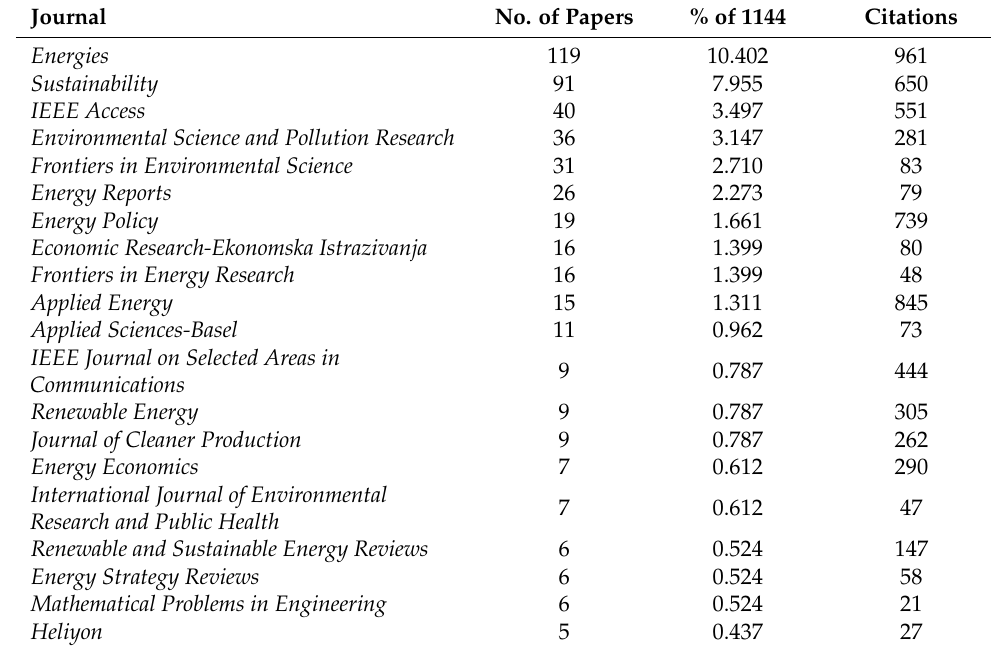
Table 2. Top 20 journals with articles on green and renewable energy and innovation.